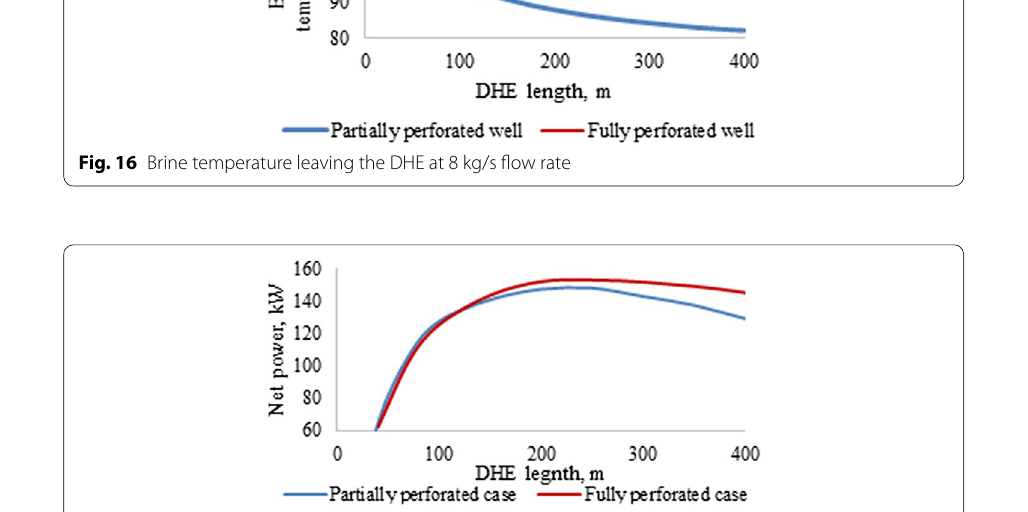
Fig. 17 Net power development change with DHE length for different perforated cases